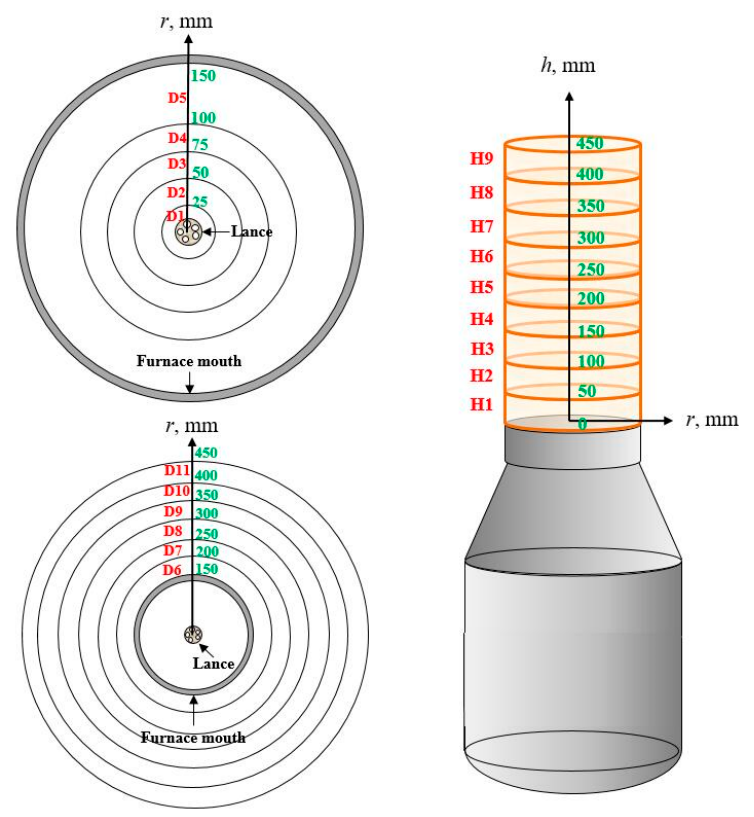
Figure 3. Measurement area division of the splashing experiment.